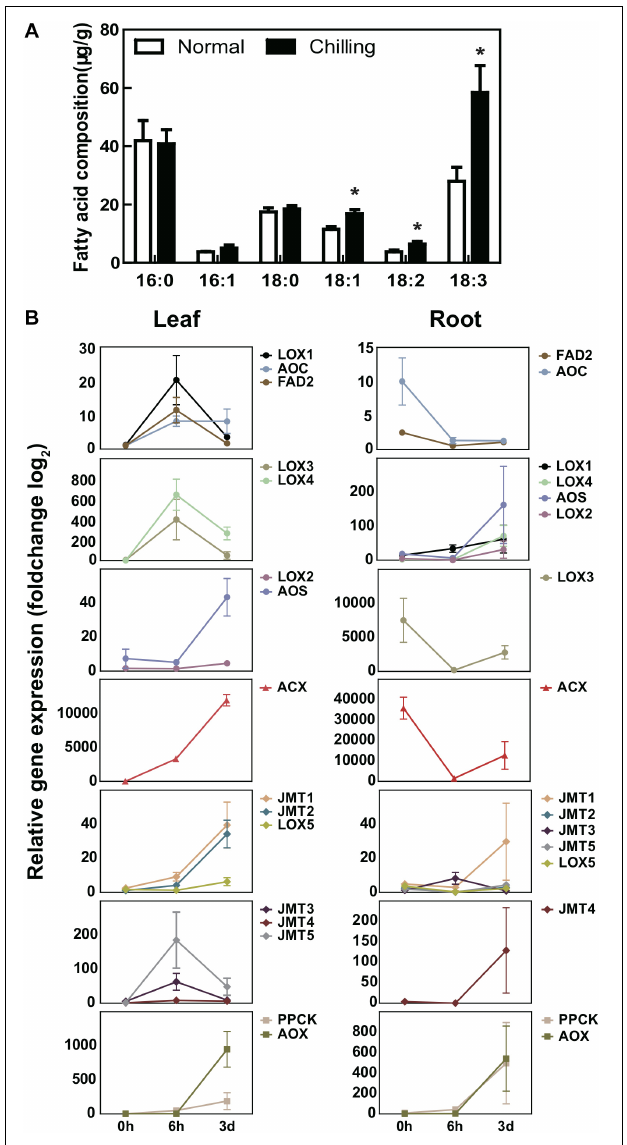
FIGURE 8 | The relative mRNA abundance of unsaturated fatty acid pathway genes under chilling stress. (A) Changes in fatty acid composition of pumpkin leaves under normal condition and after 6 h of cold treatment. Fatty acids were measured by using pumpkin first leaf in three individual plants at each time points treatment. (B) The relative abundance of pathway genes involved in the synthesis of unsaturated fatty acids in pumpkin chloroplasts, peroxisomes and mitochondria are different in leaves and roots at 0, 6, 3 d chilling stress. FAD2 , LOXs , and JMTs in leaves were first induced by chilling at 6 h and then deduced at 3 d chilling condition, but showed the opposite trend in roots. AOS showed a tendency to first decrease and then increase in both leaves and roots. AOC was up-regulated after chilling in leaves and down-regulated in roots. PPCK and ACX were both up-regulated in the leaves and roots. ACX was up-regulated in the leaves, and firstly down-regulated and then up-regulated in the roots. Different colors represented different genes. Each sample includes three replicates for the transcriptome data. Error bars indicate SD. Student t -test was used to analyzed the significant difference between mRNA abundance at 6 h, 3 d comparing with 0 h. *Indicates significant difference in ( P < 0.05). Pumpkin ACTIN gene was used as the internal reference, and the graphics are generated by GraphPad Prism